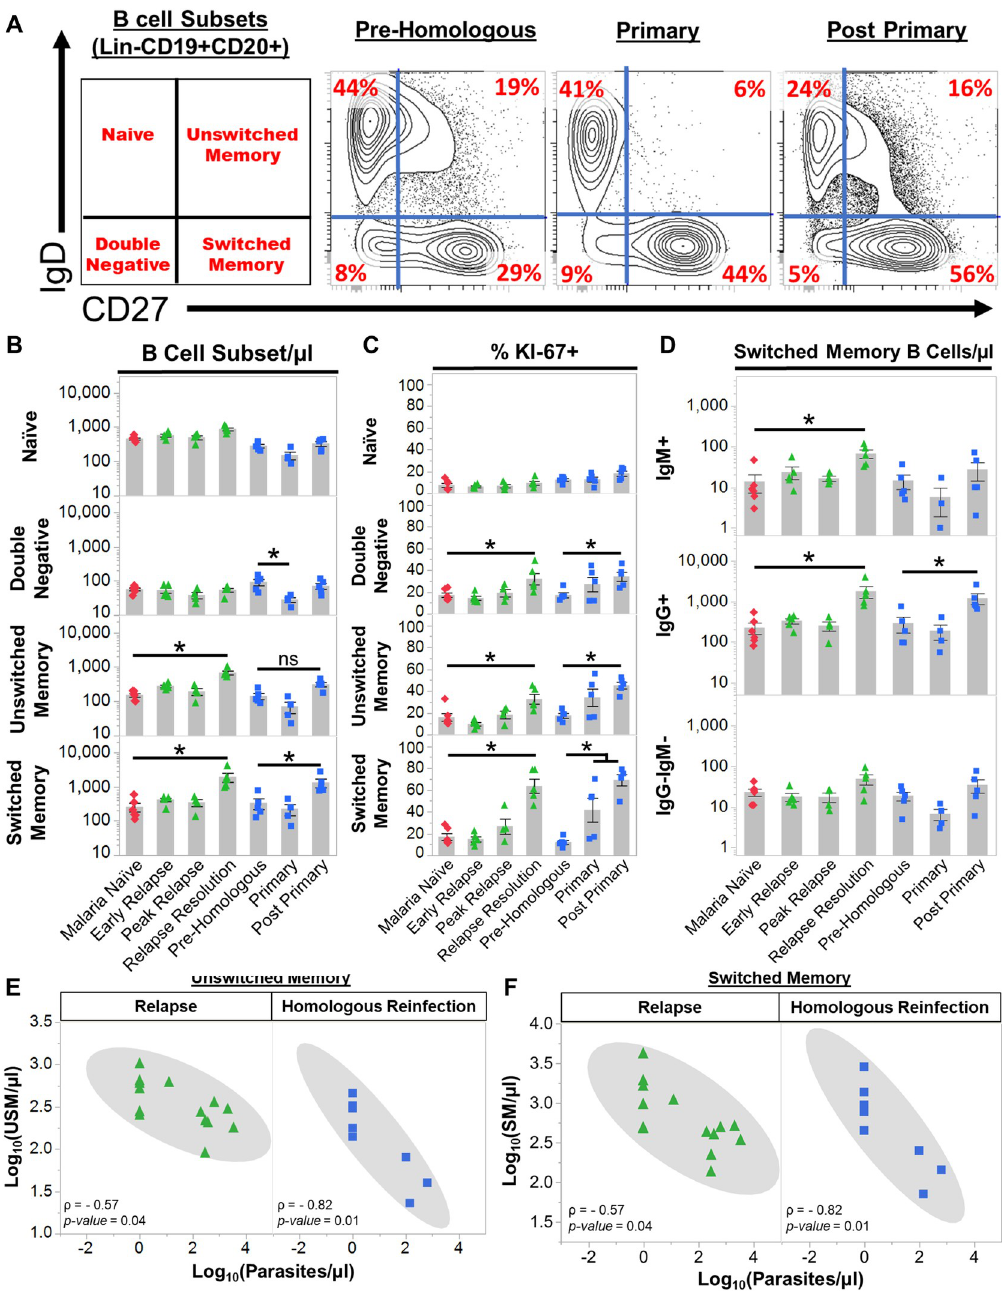
Fig 7. Homologous reinfections with P . cynomolgi induce an expansion of switched memory B cells. (a) The frequencies of four peripheral blood B cell subsets in rhesus macaques during homologous reinfections as determined by flow cytometry. A representative sample is shown. The far left panel indicates the B cell subset in each quadrant based on the gating strategy in S3 Fig. Red numbers in each quadrants indicate the percentage of each subset out of Lin-CD19+CD20+ B cells. (b) Absolute numbers of four B cell subsets at the indicated infection points. (c) The percentage of each B cell subset that is KI67+ at each infection point as determined by flow cytometry. (d) The absolute number of IgG+, IgM+, and IgG-IgM- switched memory B cells during relapses and homologous reinfections as determined by flow cytometry. (e) Spearman’s correlation analysis of the number of unswitched memory B cells and parasitemia during relapses and homologous reinfections. (f) Spearman’s correlation analysis of the number of switched memory B cells and parasitemia during relapses and homologous reinfections. Pink diamonds = malaria na ï ve, green triangles = relapse infections, blue squares = homologous reinfections. Gray bars indicate the mean of the data points shown; Error Bars = SEM. Statistical significance was assessed by a linear mixed effect model using a Tukey-Kramer HSD post-hoc analysis. Asterisks indicate a p-value < 0.05. ρ = Spearman’s correlation